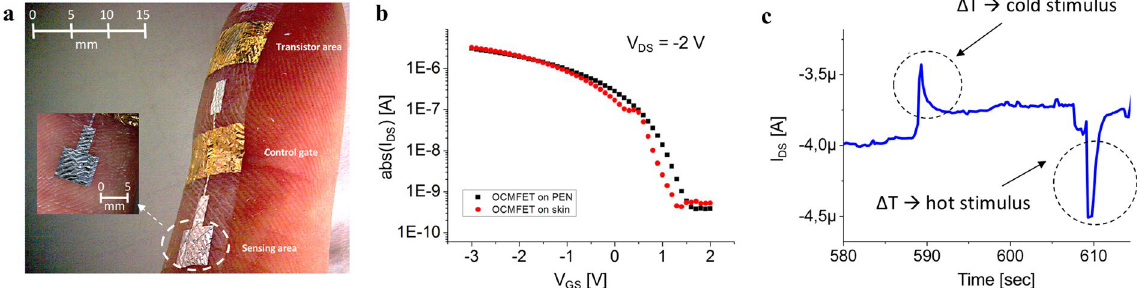
Figure 5. OCMFET electrical characterization on skin. ( a ) OCMFET placed on the skin, demonstrating its good conformability. ( b ) Electrical characterisation of the device before being peeled-off from the PEN carrier and after its placement onto the skin. ( c ) Preliminary results of the temperature sensing on